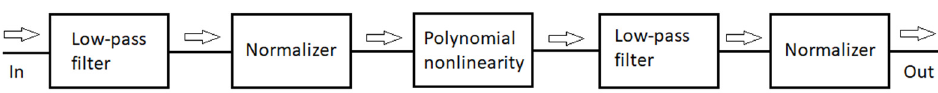
Figure 2. Block schematic of the Wiener–Hammerstein filter modeling the dynamic nonlinearity.